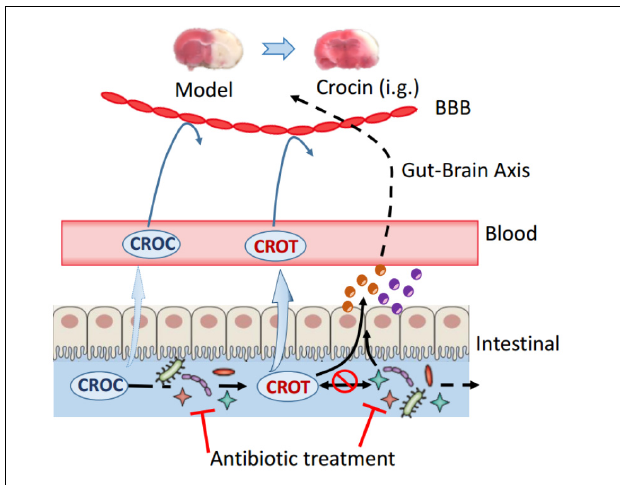
FIGURE 8 | Proposed active target of orally administered crocin on cerebral I/R injury. Oral administration of crocin elicits a superior cerebral protective effect over intravenous administration, and both crocin and crocetin could not cross the blood brain barrier even in rats with cerebral I/R injury. Direct intravenous administration of crocetin could not reduce the brain infarction volume or improve neurological behavior indicating that the crocetin in circulation system does not account for the cerebral-protective effects of crocin. Crocin could be easily deglycosylated to crocetin by gut flora, meanwhile, crocetin was also metabolized by the gut flora. However, trace levels of crocetin could be found after the incubation of crocin with the gut flora of pGF rats, and the gut flora of pGF rats was no longer capable to metabolize crocetin. Additionally, the cerebral-protective effect of orally administered crocin disappeared in pGF rats. Our study from the insight of reverse pharmacokinetics hints to the possibility that the gut flora might be the potential target of crocin and crocetin, although the details connecting the gut flora and stroke prognosis remain largely unclear. BBB, blood brain barrier; CROC, crocin; CROT, crocetin; Brown and purple circles represent some bioactive